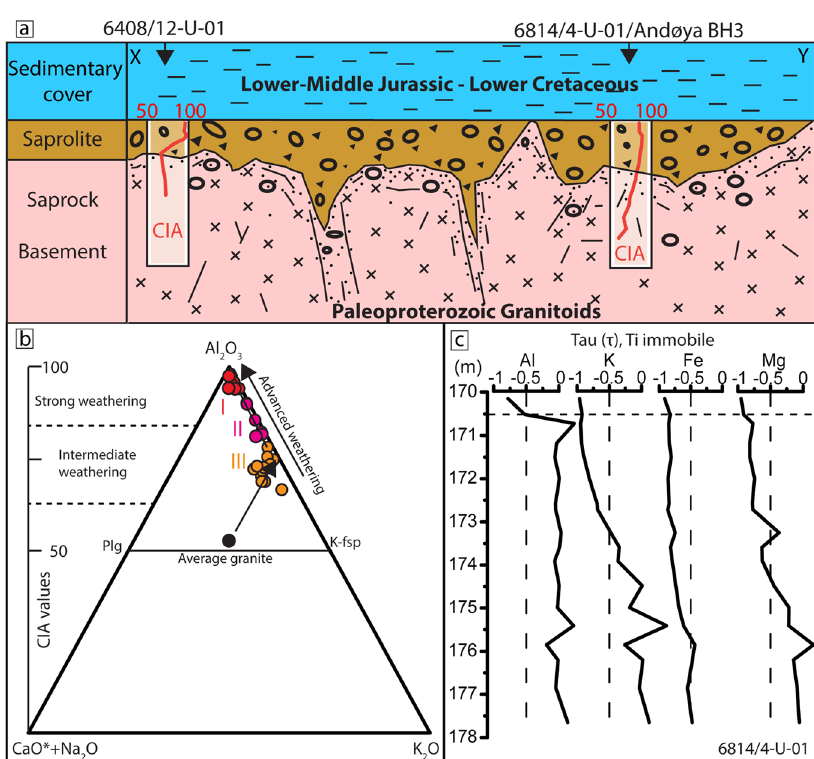
Fig. 4 Simpli fi ed geology and geochemical characterization of the weathered basement. a Simpli fi ed geological pro fi le of fresh and weathered (saprolitic) crystalline basement overlain by Mesozoic sediments (not to scale). CIA chemical index of alteration pro fi les approaching values of 100 show the weathering zones in each basement section from the three studied locations. b CN-A-K (CaO + Na 2 O, Al 2 O 3 , K 2 O) plot with weathering indices (CIA), and weathering zonations I (red, strong weathering), and II-III (purple to orange, intermediate weathering) of granitoid bedrock according to Nesbitt and Young 37 . Average granite composition (black dot) and its intermediate to strong/advanced weathering trends (arrows) 46,47 support the inferred saprolitization of the studied granitoid basement below Mesozoic cover. c Mass balance with strain (tau, translocation) of well 6814/4-U-01 versus depth (in m) assuming immobile Ti. The stippled line indicates the transition between the weathered basement and Mesozoic cover. (maximum) age of the weathering episode. This is because the fi nest fractions contain the highest amount of authigenic K-bearing minerals and the least of potential contaminating mineral phases derived from the protolithic weathered rock 20,29,30 .